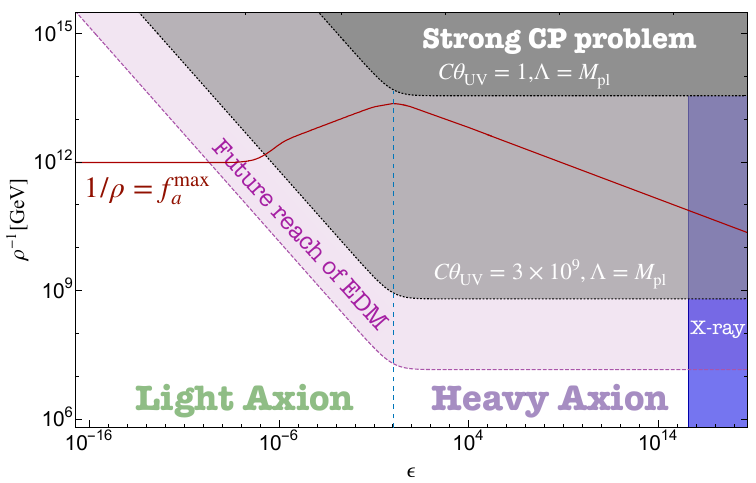
Figure 3 . The parameter region of the QCD axion with aligned small instanton in (cid:15) - ρ plane with Λ = M pl . The light gray and gray regions are excluded by the too large neutron EDM with Cθ UV = 3 × 10 9 and 1 , respectively. The purple shaded range above the dashed line may be tested in future EDM searches with Cθ UV = 3 × 10 9 . On the upper frame, the maximal axion decay constant from the axion abundance is denoted (see section 3). The red solid line represents 1 /ρ = f max blue region is excluded by X-ray observation (by assuming dominant dark